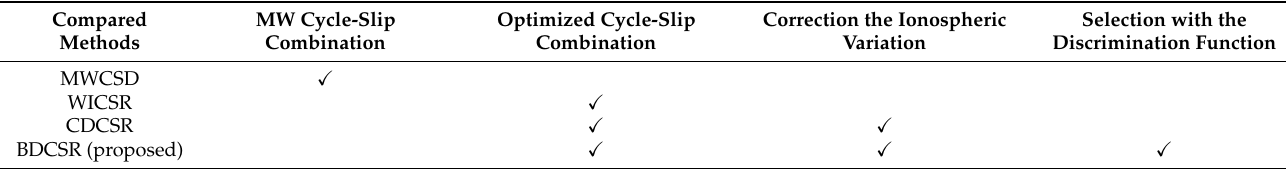
Table 4. The comparison of different testing